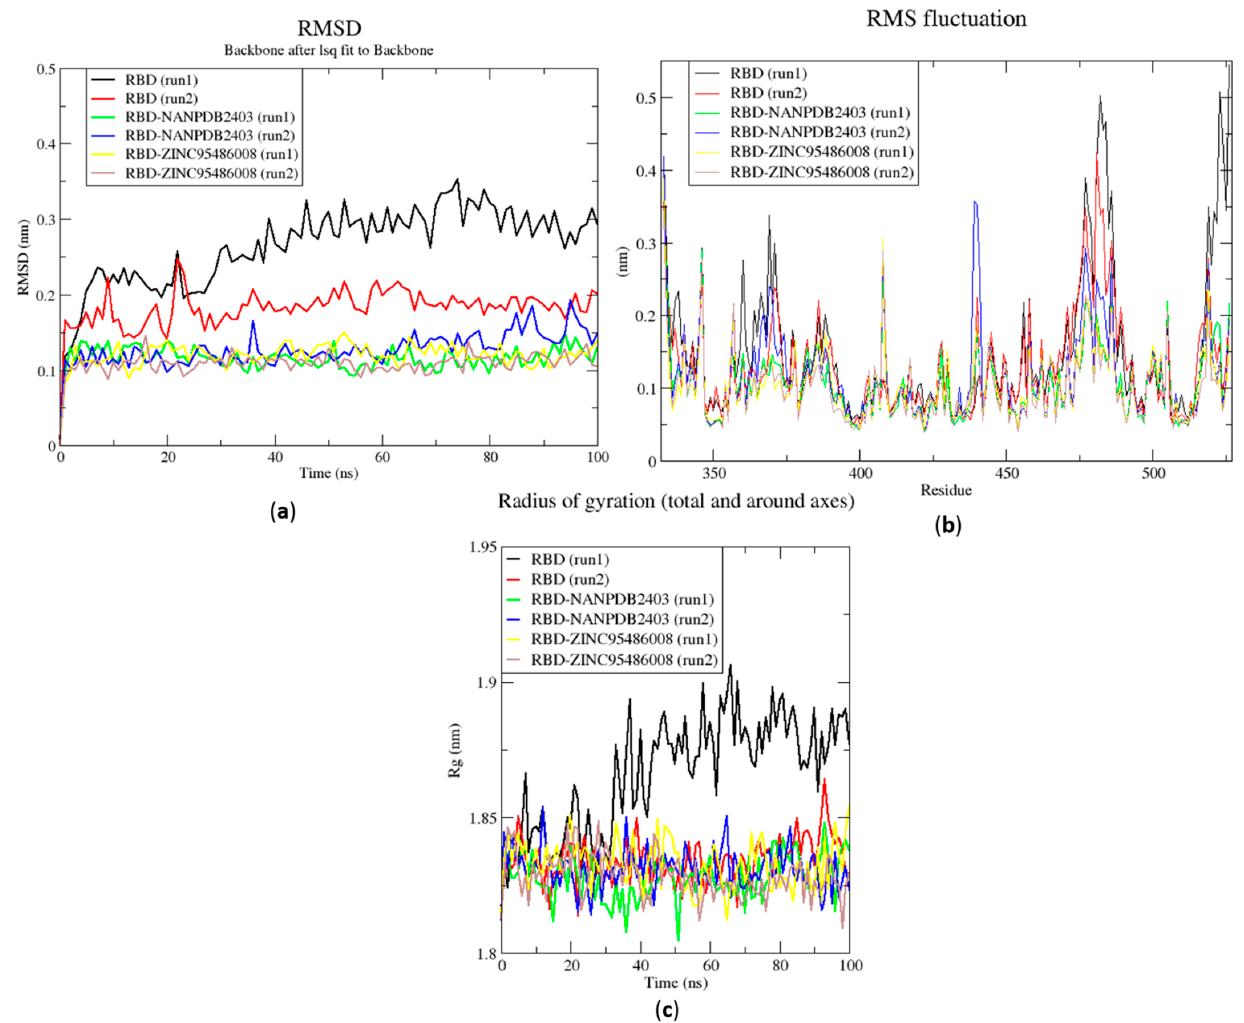
Figure 6. RMSD, RMSF and Rg plots of the extended MD simulations of the RBD-ligand complexes generated over 100 ns using GROMACS. ( a ) RMSD versus time graph of the RBD-ligand complexes, ( b ) analysis of RMSF trajectories of residues of the RBD-ligand complexes, and ( c ) Rg versus time graph of the RBD-ligand complexes. In all the three graphs, the unbound RBD, unbound RBD duplicate run, RBD-NANPDB2403, RBD-NANPDB2403 duplicate run, RBD-ZINC000095486008, and RBD-ZINC000095486008 duplicate run are shown as black, red, green, blue, yellow and brown, respectively.